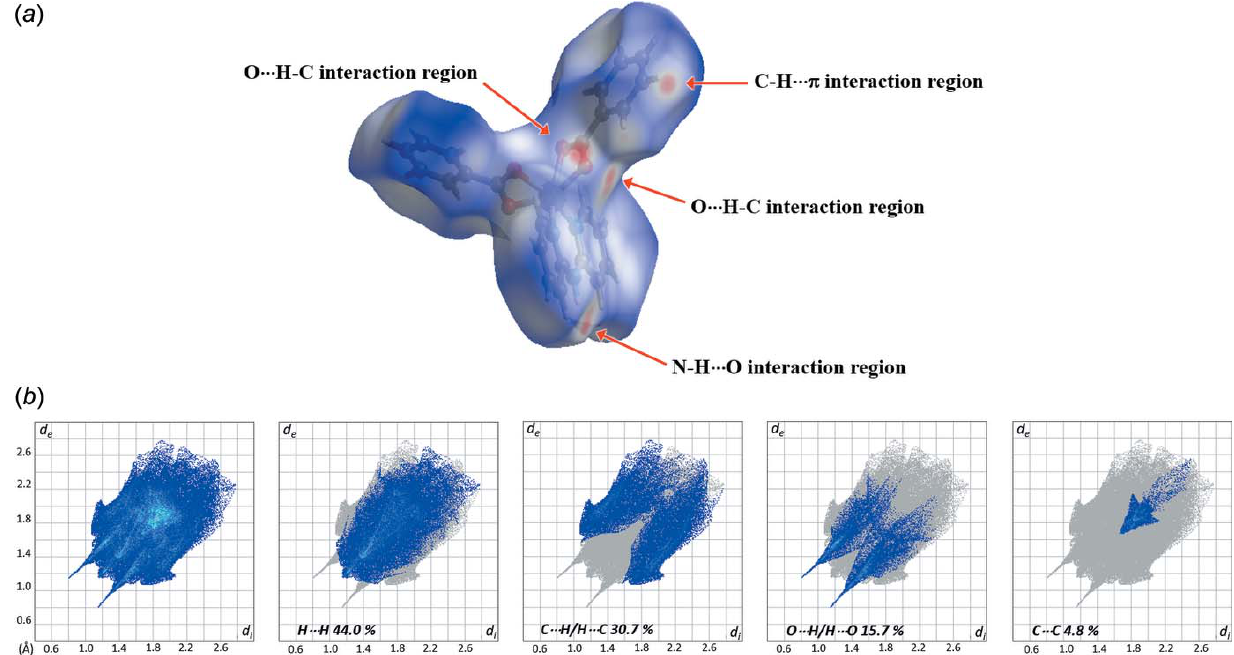
Figure 5 Views of ( a ) the Hirshfeld surface mapped over d norm in the range (cid:4) 0.526 to +1.5208 (arbitrary units) and ( b ) Hirshfeld surface fingerprint plots for the H (cid:2)(cid:2)(cid:2) H, C (cid:2)(cid:2)(cid:2) H/H (cid:2)(cid:2)(cid:2) C, O (cid:2)(cid:2)(cid:2) H/H (cid:2)(cid:2)(cid:2) O and C (cid:2)(cid:2)(cid:2) C contacts of the title